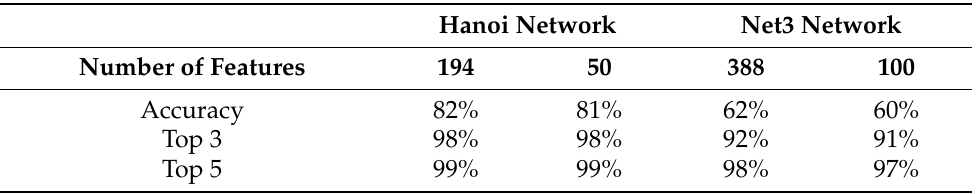
Table 7. Influence of number of features on model accuracy for the Hanoi and Net3 networks with an emitter coefficient range of 10–15 and a demand variation of ± 2.5% with 500,000 inputs. Hanoi Network Net3